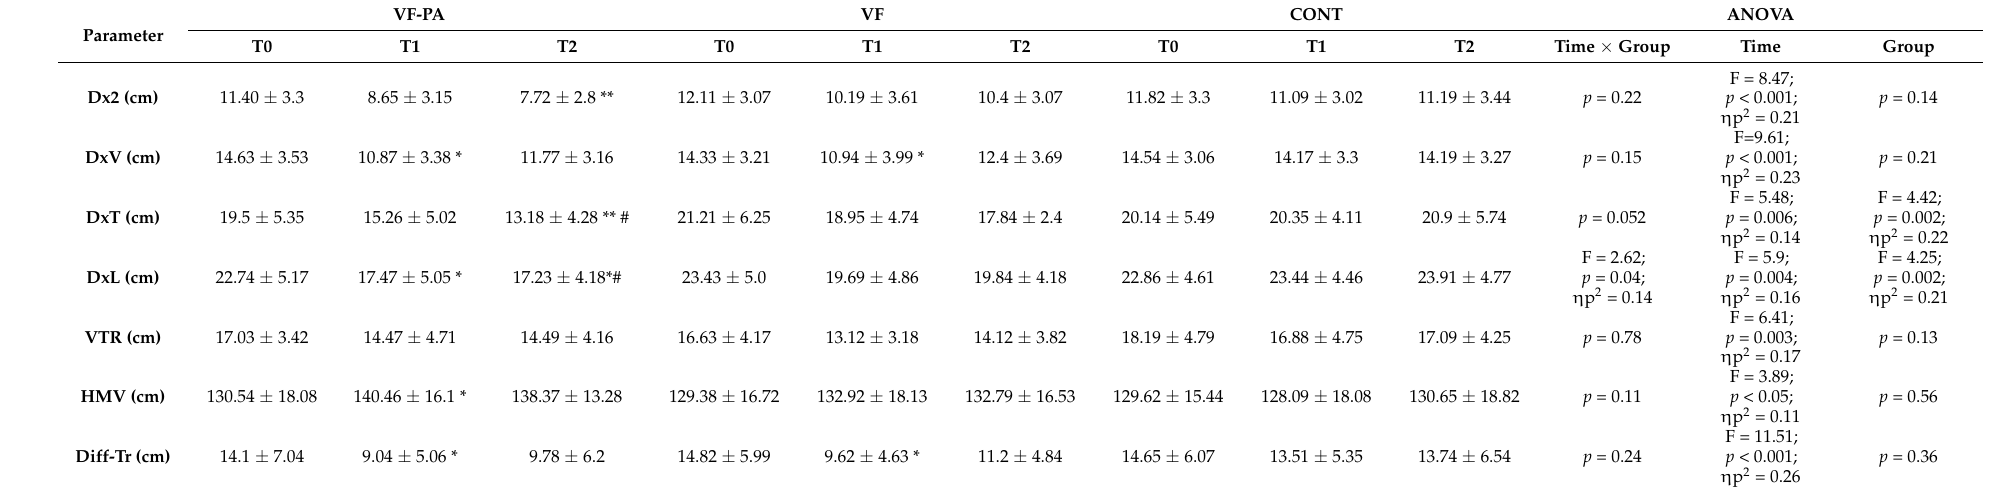
Table 2. Kinematic parameters (mean ± standard deviation) at T0, T1 and T2 among the three tested